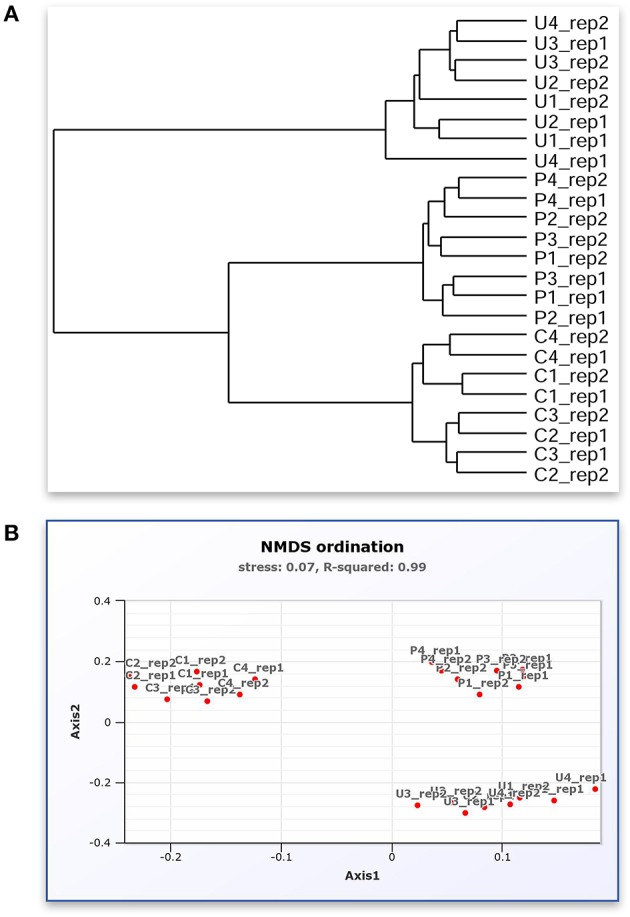
A screenshot montage of MetaAmp output in different view. (A) Mock sample relation dendrogram describes the similarity of the mock samples to each other measured by Bray-Curtis dissimilarity distance. (B) Mock sample NMDS analysis based on the Bray-Curtis dissimilarity distance.